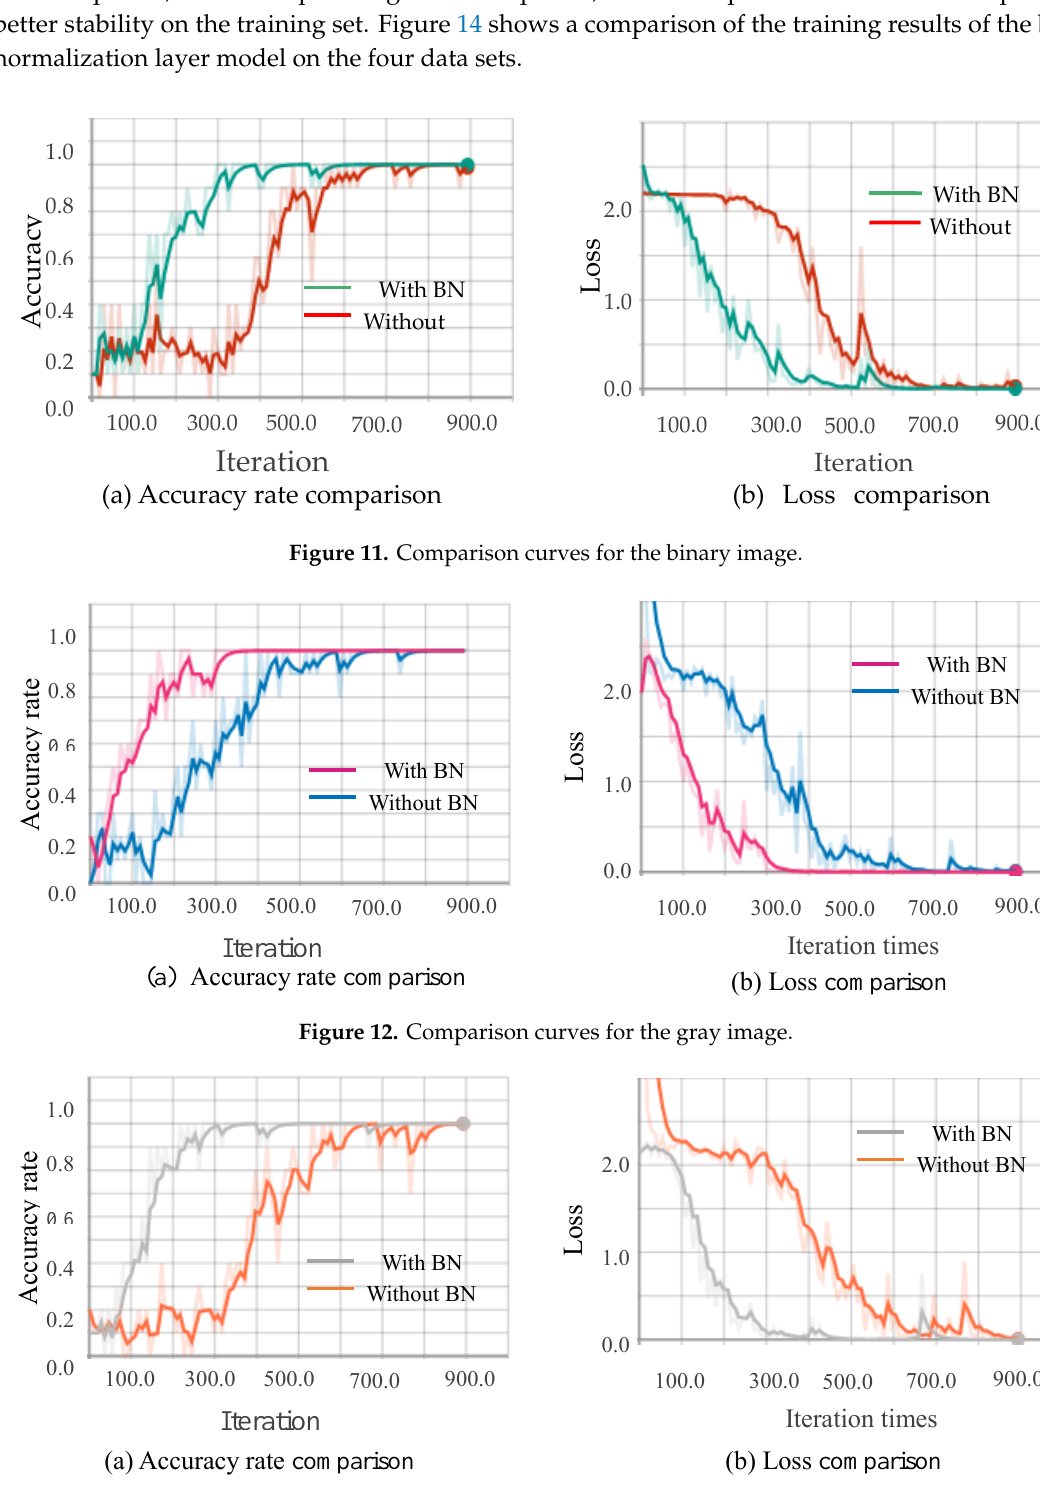
Figure 13. Comparison curves for the depth image.